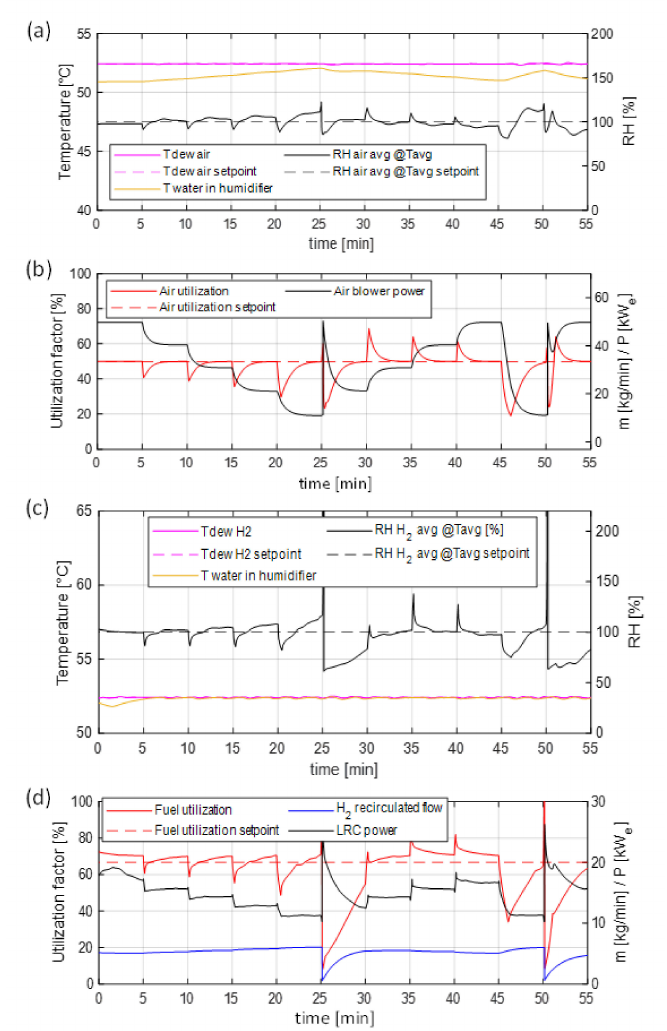
Figure 5. Simulation of load-following operation: time profile of ( a ) air dew point temperature at stack inlet vs setpoint, water temperature in the air humidifier tank, and air average RH vs setpoint; ( b ) air utilization factor vs setpoint, and air blower power consumptions; ( c ) hydrogen dew point temperature at stack inlet vs setpoint, water temperature in the hydrogen humidifier tank and hydrogen average RH vs setpoint; ( d ) fuel utilization factor vs setpoint, hydrogen mass flowrate recirculated over the compressor and LRC power